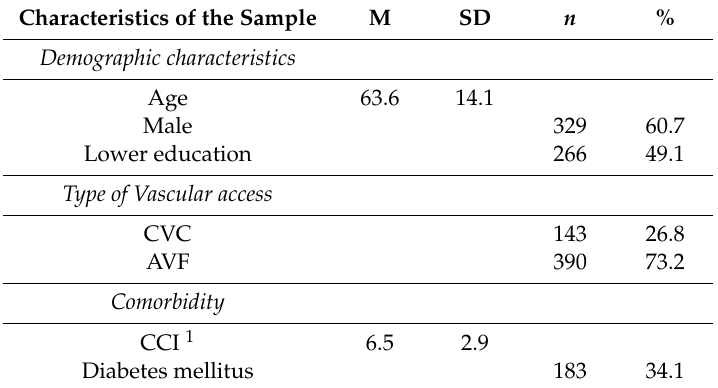
Table 1. Characteristics of the sample: age, gender, education, type of vascular access (VA), and comorbidity; frequencies or means ( n =